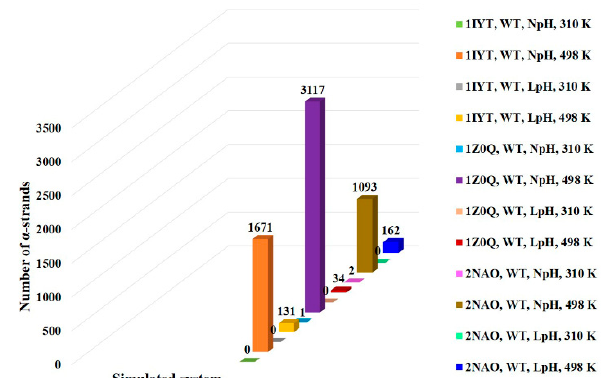
Figure 2. Comparison of the number of α -strands observed in region 24–26 for the simulated systems. Simulations at high temperature (498 K) showed a high number of α -strands as compared to the physiological temperature (310 K) for all the simulated PDBs. LpH simulations displayed a lower number of α -strands than NpH simulations.